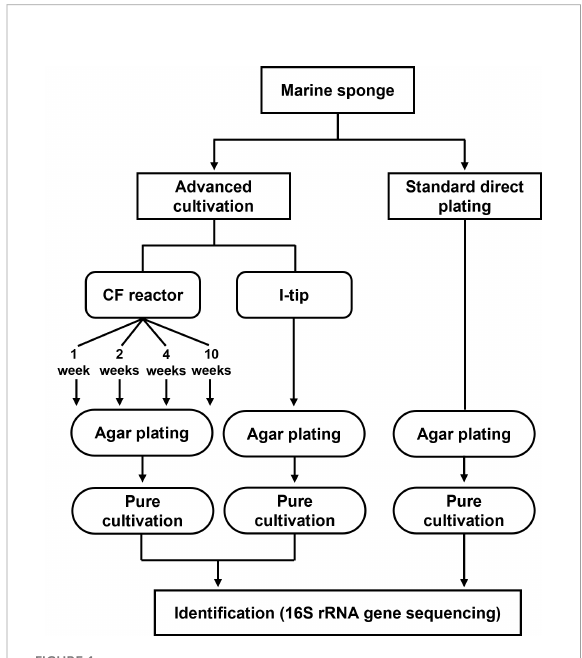
FIGURE 1 Flowchart showing the methods for bacterial